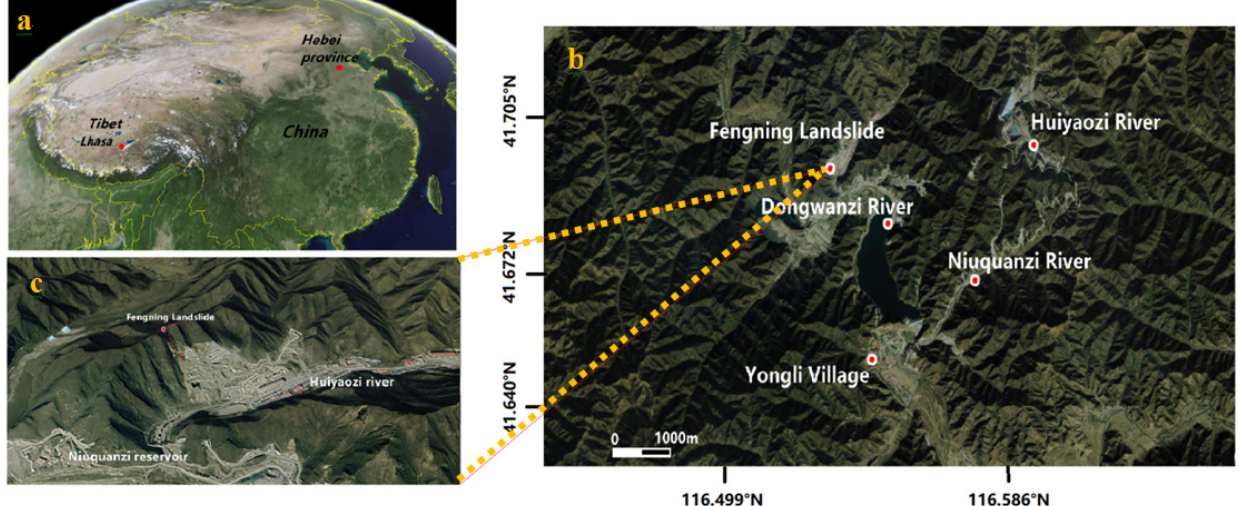
Figure 1. Maps of the study area location: ( a ) Hebei province; ( b ) Fengning landslide; ( c ) scope of the landslide.